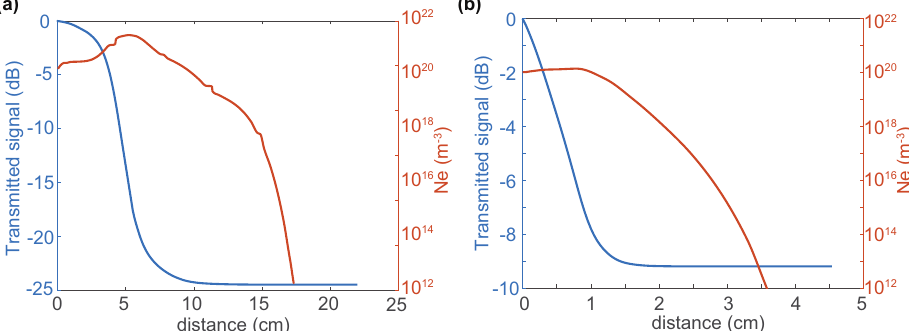
Figure 5. ( a ): The signal attenuation in the plasma sheath of the blunt coned vehicle and the electron density distribution for blunt coned vehicle along the propagation path. ( b ): The signal attenuation in the plasma sheath of the sharp coned vehicle and electron density distribution for the sharp coned vehicle along the propagation